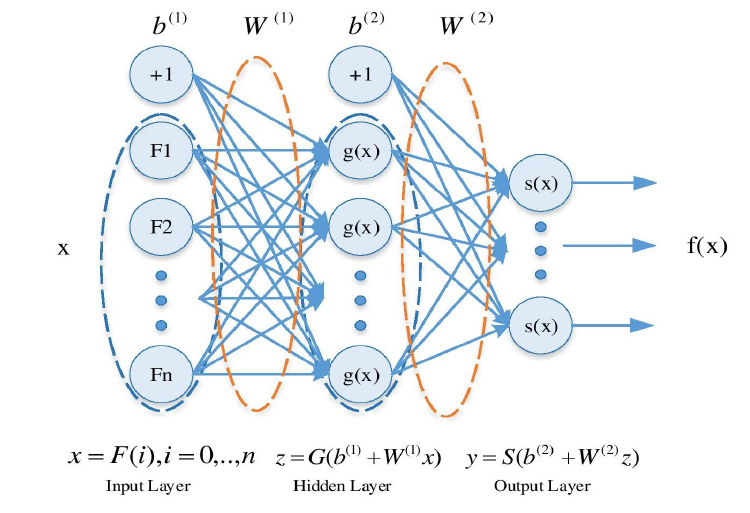
Figure 2. A Multi-Layer Perceptron with One Hidden